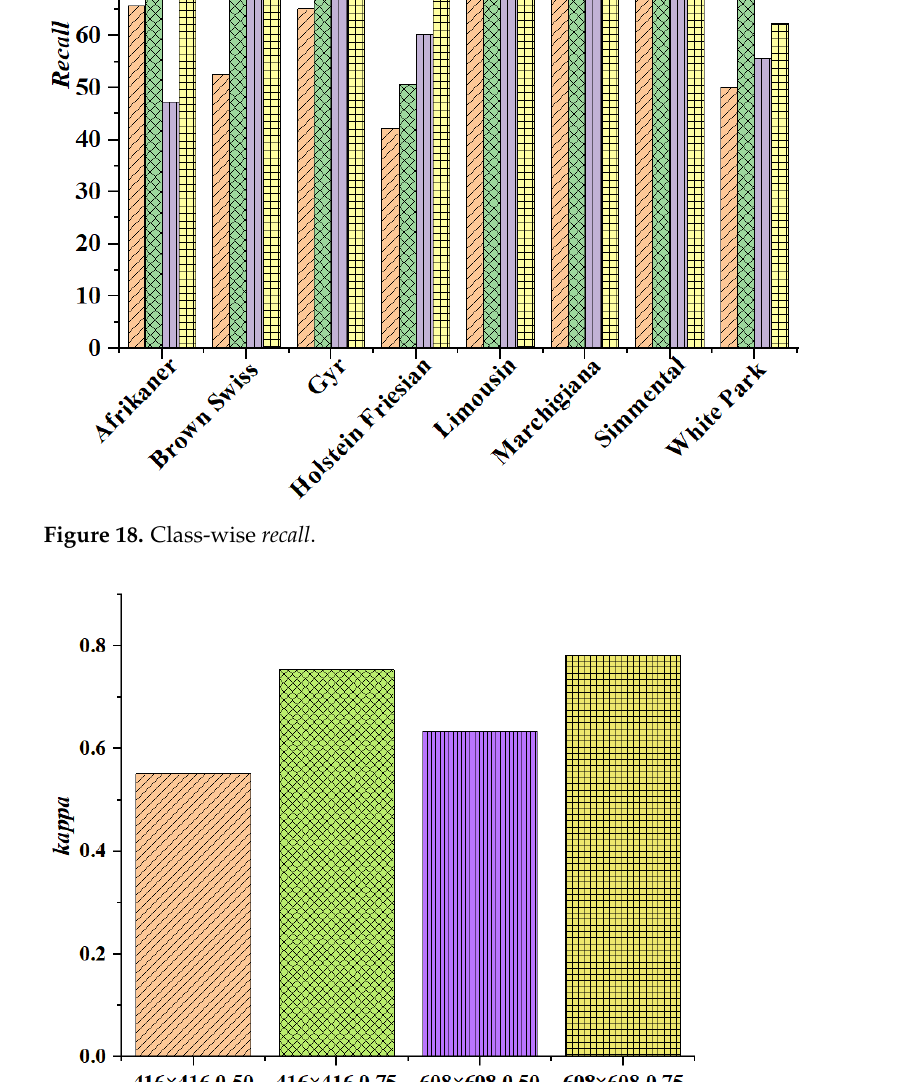
Figure 19. Kappa values quantified from the confusion matrix.